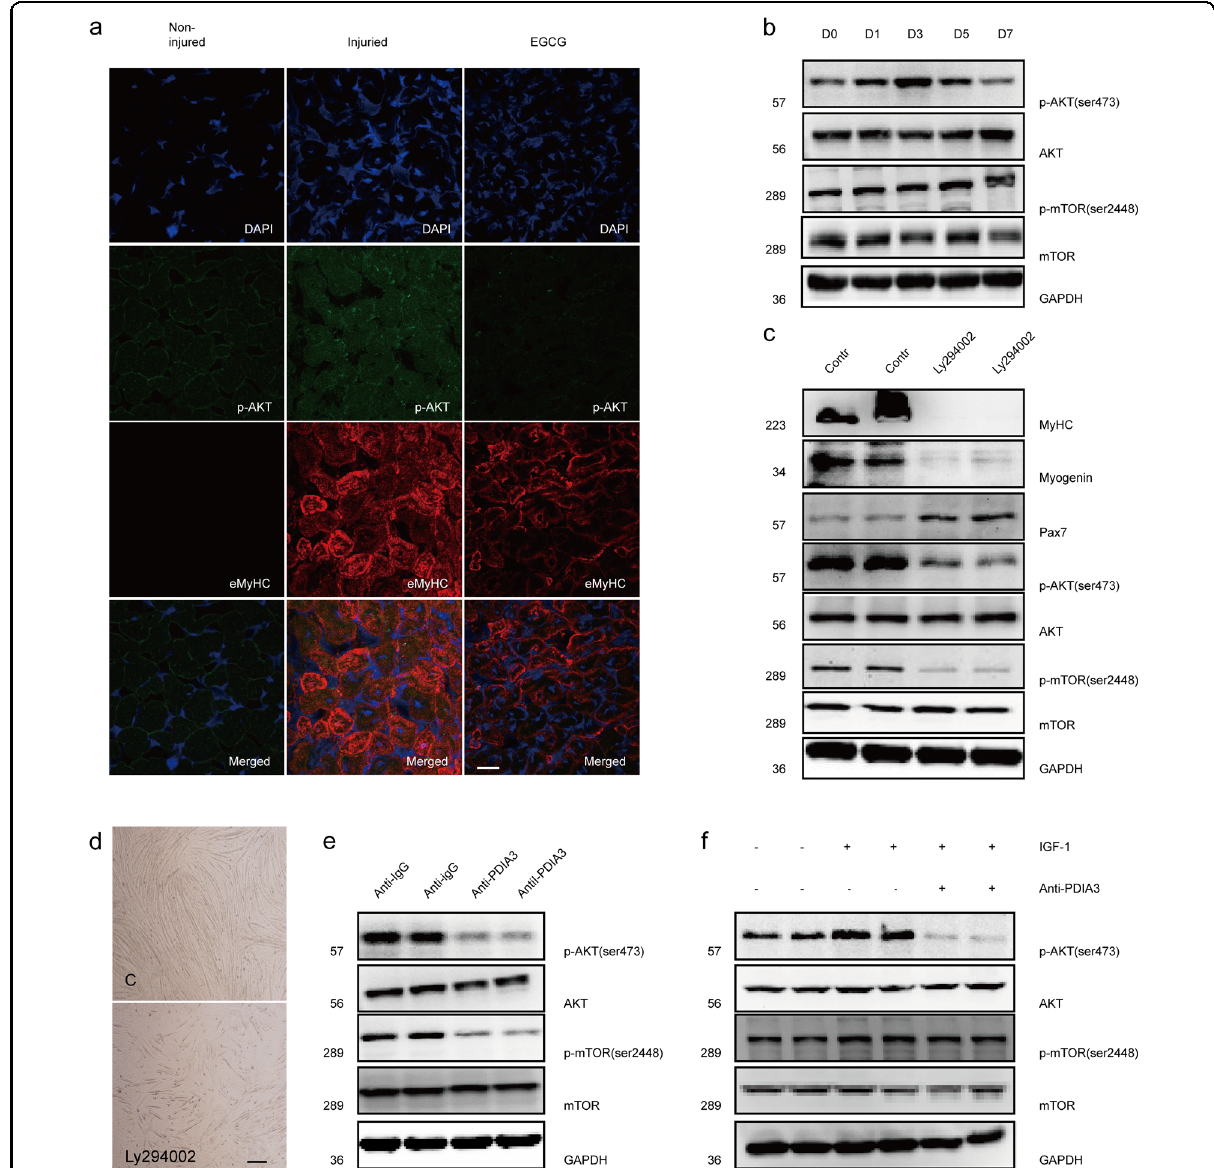
Fig. 7 PDIA3 regulates myoblast differentiation through AKT/mTOR signaling. a The gastrocnemius in mice was injured by the direct injection of 100 µl CTX (10 µM) and the intraperitoneal injection of EGCG. On day 7 post injury, the gastrocnemius was harvested from euthanized mice. Frozen sections of gastrocnemius muscle were subjected to the immuno fl uorescence staining of p-AKT and eMyHC. Scale 20 µm. b C2C12 myoblasts were induced to differentiate for 1, 3, 5, and 7 days. The levels of the p-AKT, AKT, p-mTOR, and mTOR proteins were assessed by immunoblotting ( n = 4). c C2C12 myoblasts were induced to differentiate for 48 h and treated with LY90042. After 24 h, the levels of the MyHC, myogenin, p-AKT, AKT, p-mTOR, and mTOR proteins were assessed by immunoblotting ( n = 4). d C2C12 myoblasts were induced to differentiate for 48 h and treated with LY90042. After 72 h, myotube formation was observed by a microscope. Scale 200 µm. e C2C12 myoblasts were induced to differentiate for 48 h, followed by treatment with an anti-PDIA3 antibody for 24 h. The expression of p-AKT, AKT, p-mTOR, and mTOR were measured by immunoblotting ( n = 4). f C2C12 myoblasts were induced to differentiate for 48 h and treated with IGF-1 (2 µg/ml) for 24 h in the absence or presence of anti-PDIA3 (10 µg/ml) antibody. The levels of the p-AKT, AKT, p-mTOR, and mTOR proteins were measured by immunoblotting ( n =